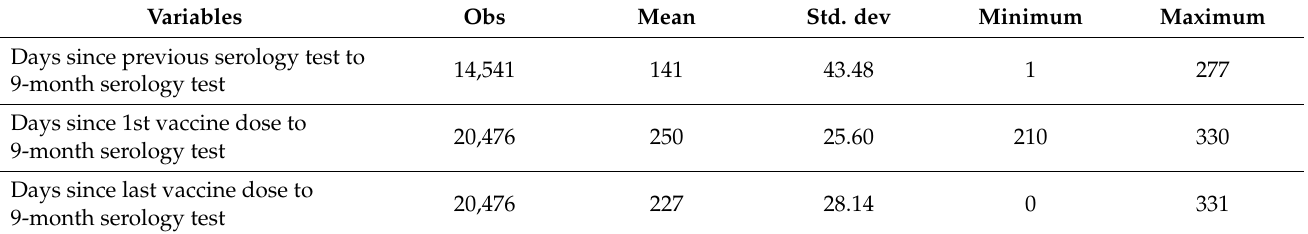
Table 2. Quantitative summary of days since previous serology test to 9-month serology test, days